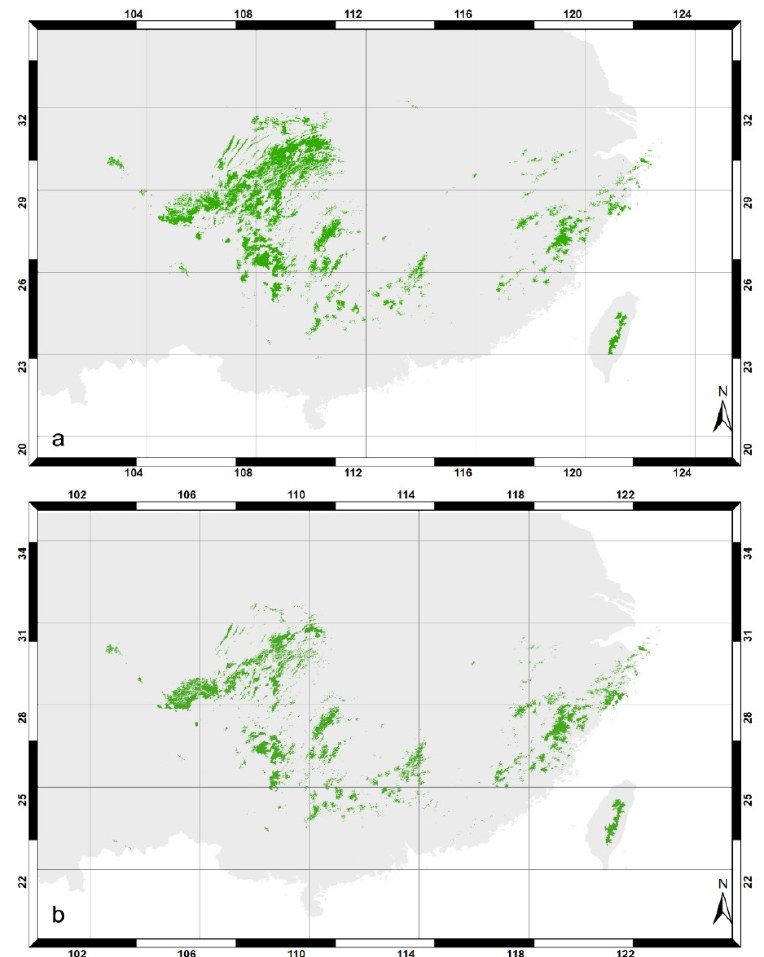
Figure 6. High productive sites (>450 m 3 /ha stand volume) within predicted present areas; ( a ) A1B projection; ( b ) A2